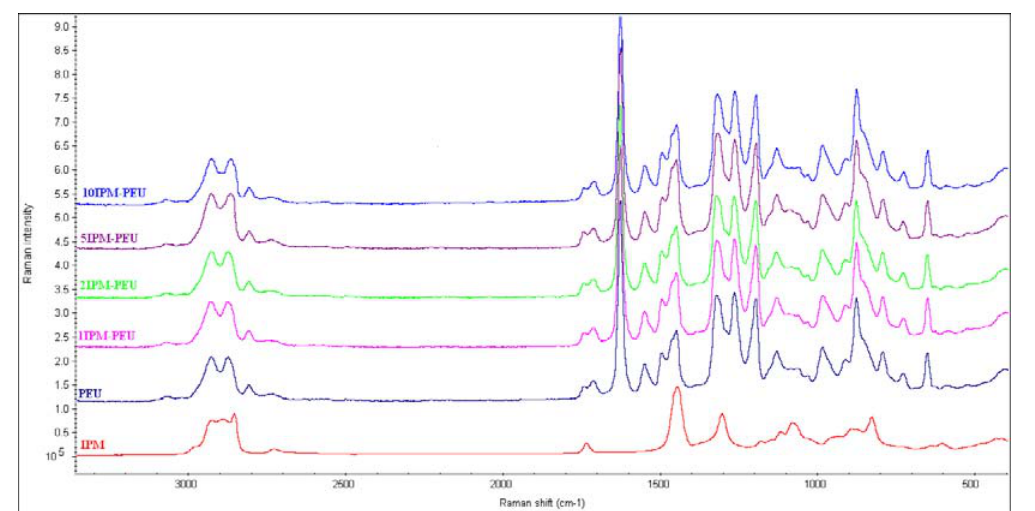
Figure 3. Raman Spectra of polyether-urethanes loaded with IPM compared with Raman spectrum of